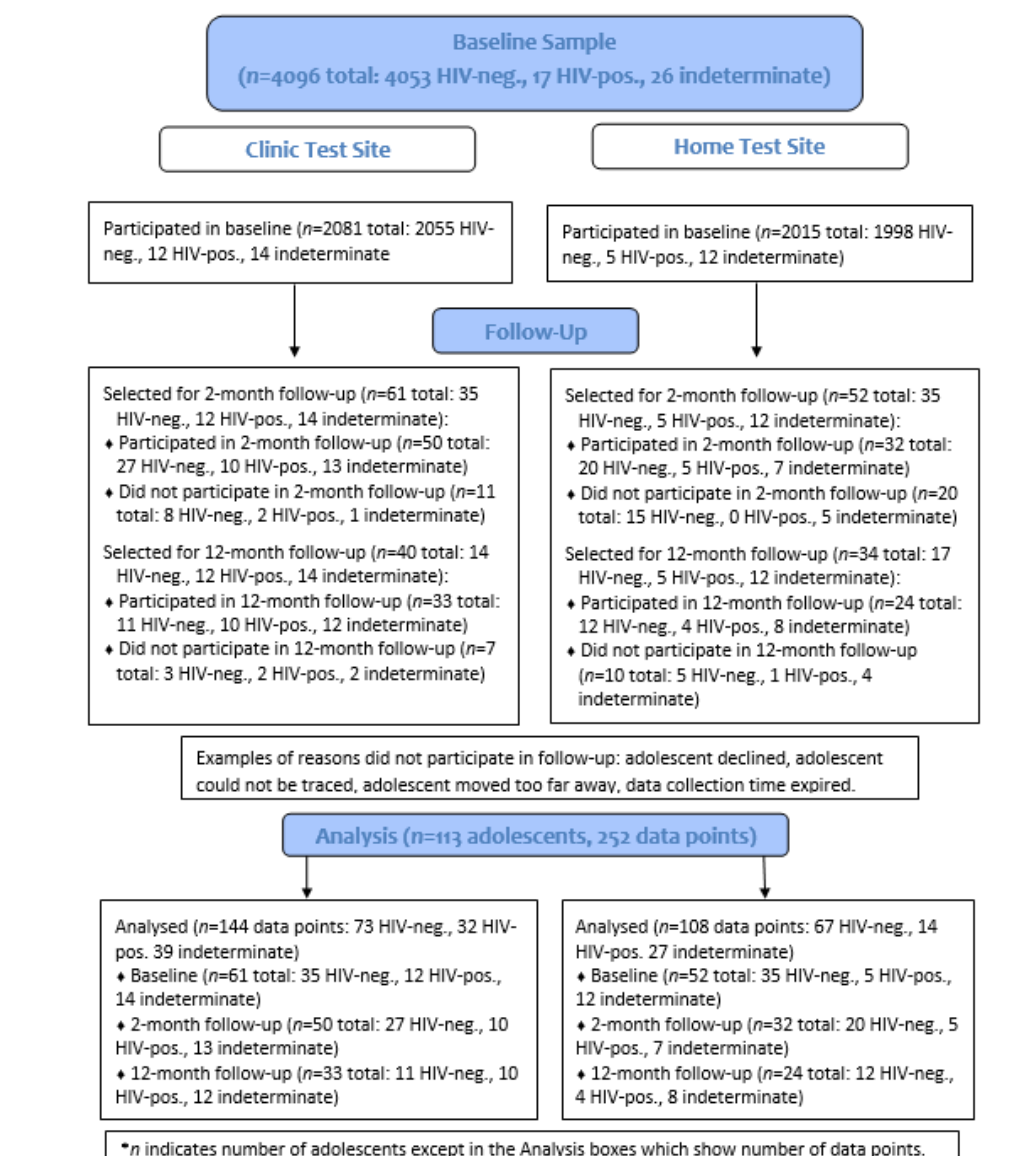
Table 1. Baseline Characteristics of Full Sample and Follow-up Sample. Baseline Characteristic .